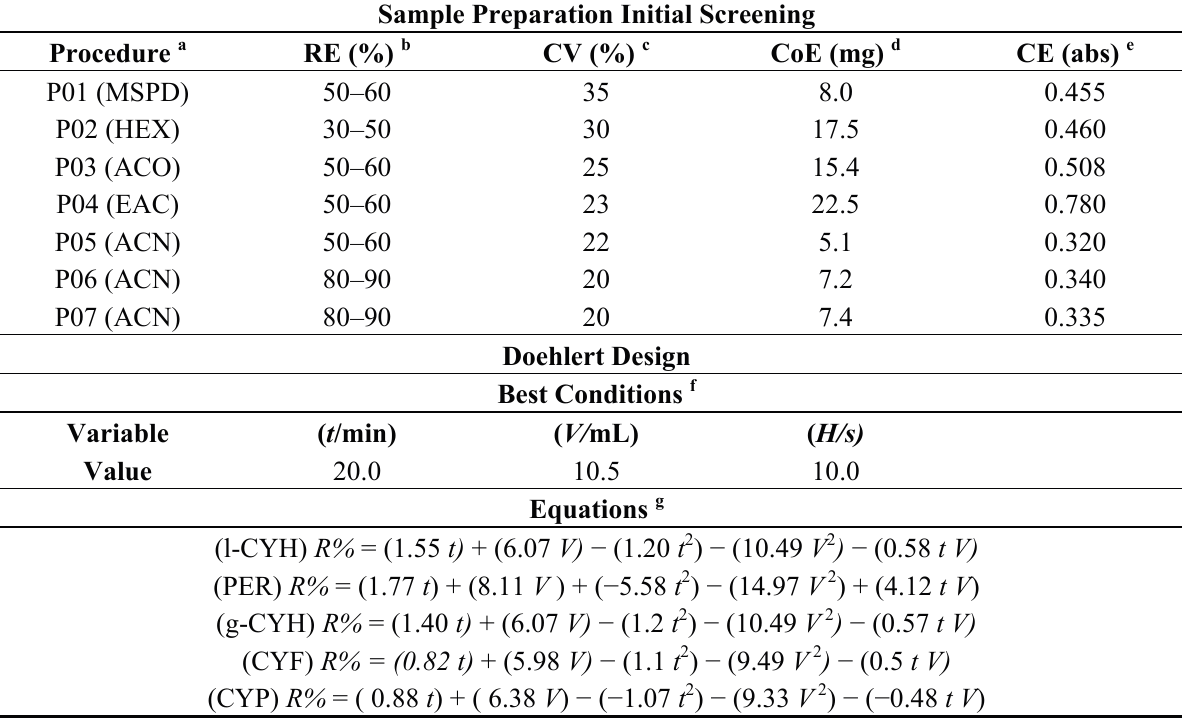
Table 3. Recoveries obtained in screening evaluation of sample preparation method and in the optimized condition using Doehlert design